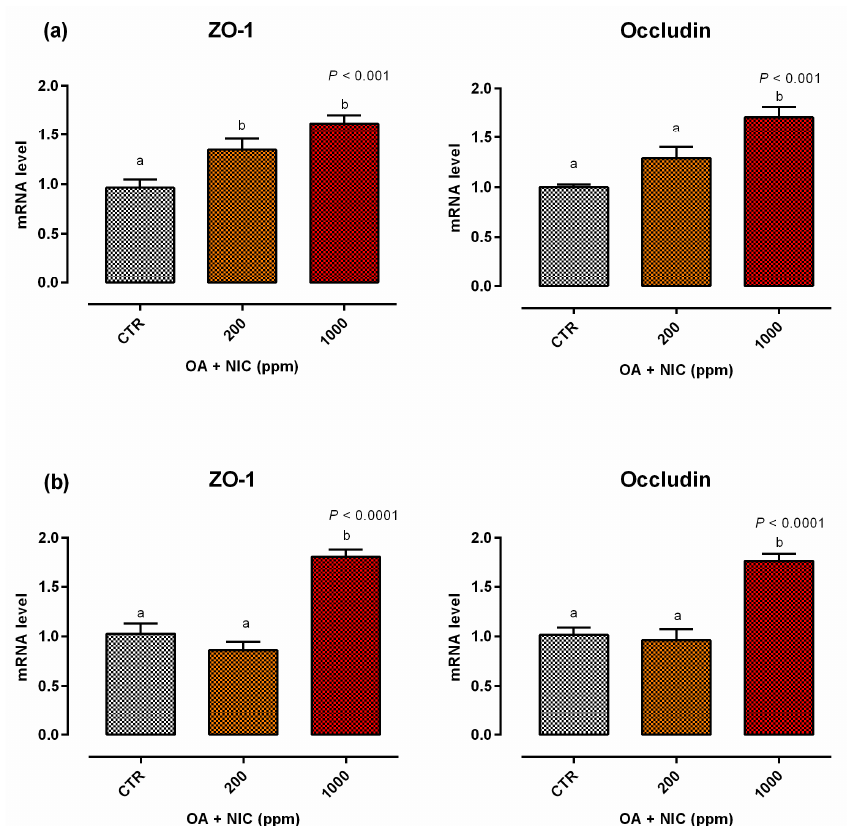
Figure 10. Gene expression in Caco-2 cells after 15 days of treatment with OA + NIC and subjected to an inflammatory challenge. Values are least square means ( n = 6) ± SEM represented by vertical bars. A modification of the 2 – ∆∆ CT method [16] was used to analyze the relative expression (fold changes), calculated relative to the control group. Means with di ff erent letters indicate statistical significance with p < 0.05 (a, b); means with at least one common letter are not significantly di ff erent (ab). CTR